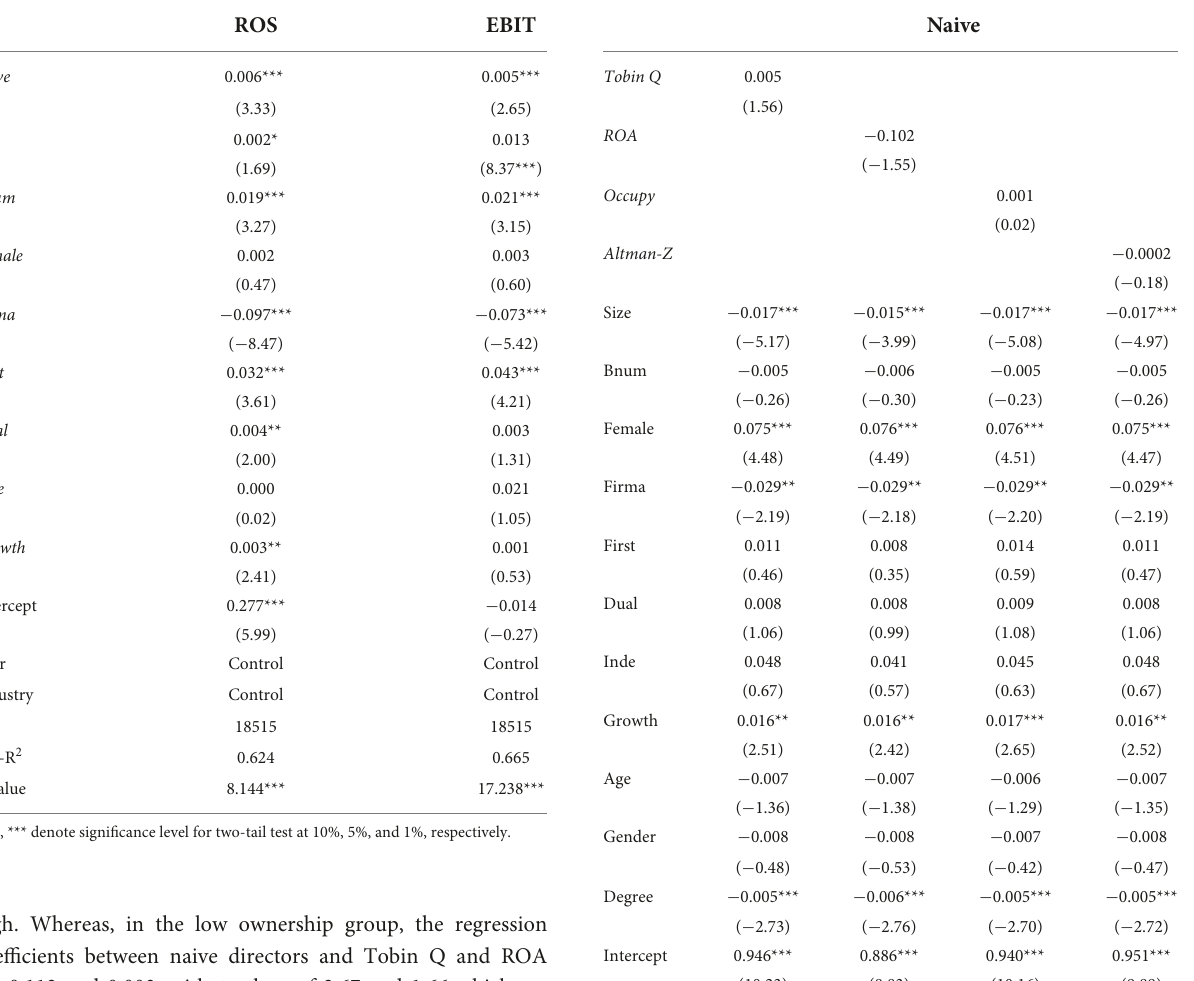
TABLE 7 Alternative measures of firm performance. TABLE 8 Regression analysis of reverse